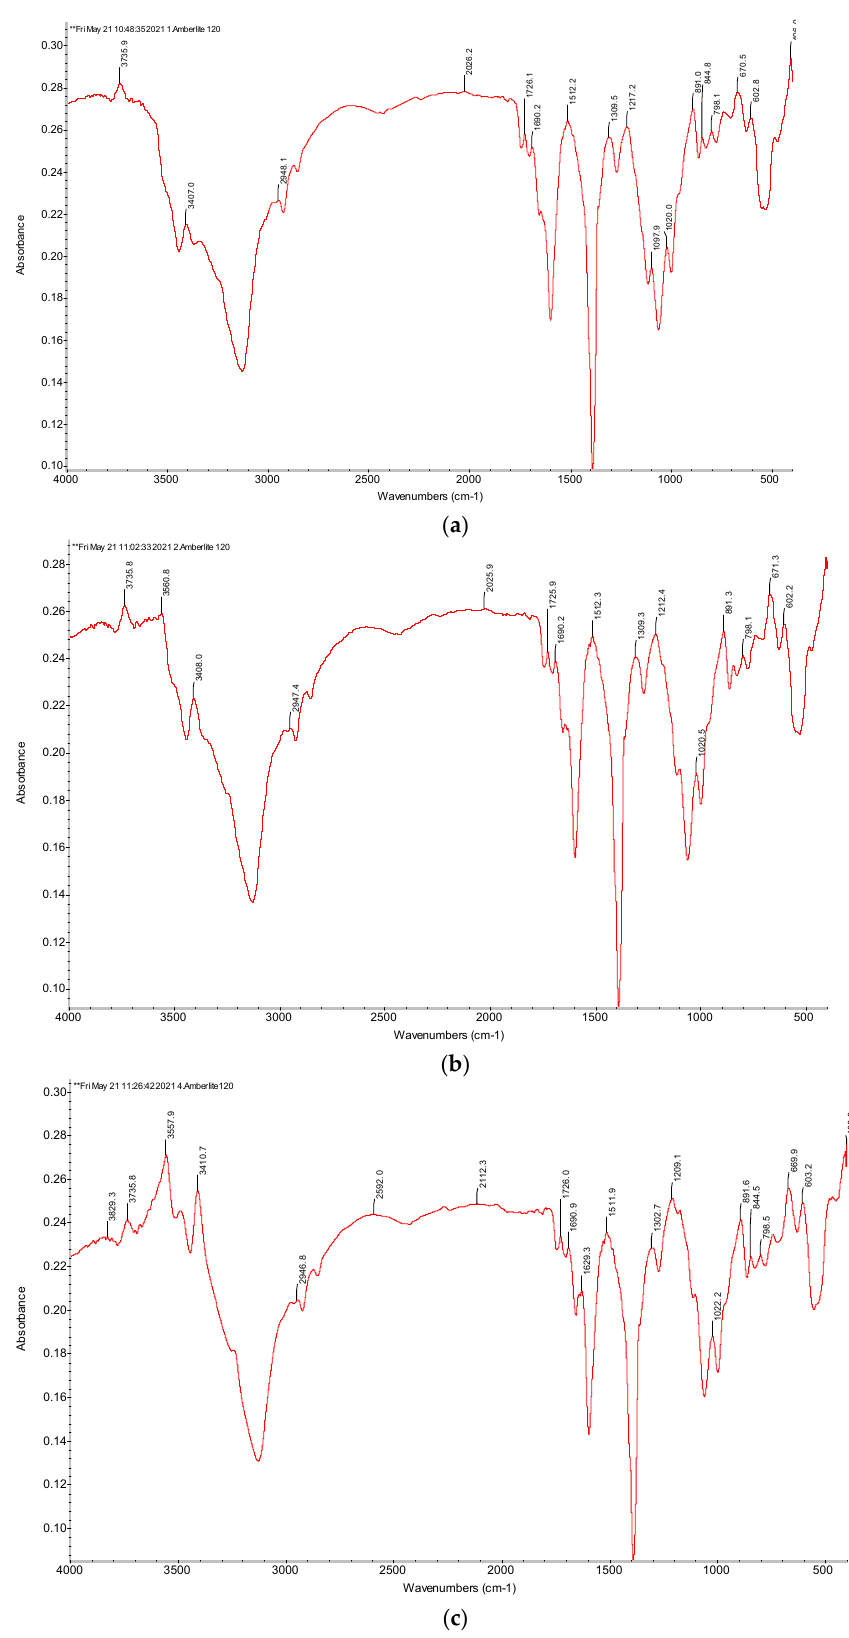
Figure 9. Fourier transform infrared (FTIR) spectra of ( a ) Amberlite IR120; ( b ) Amberlite IR120 6:0; ( c ) Amberlite IR120